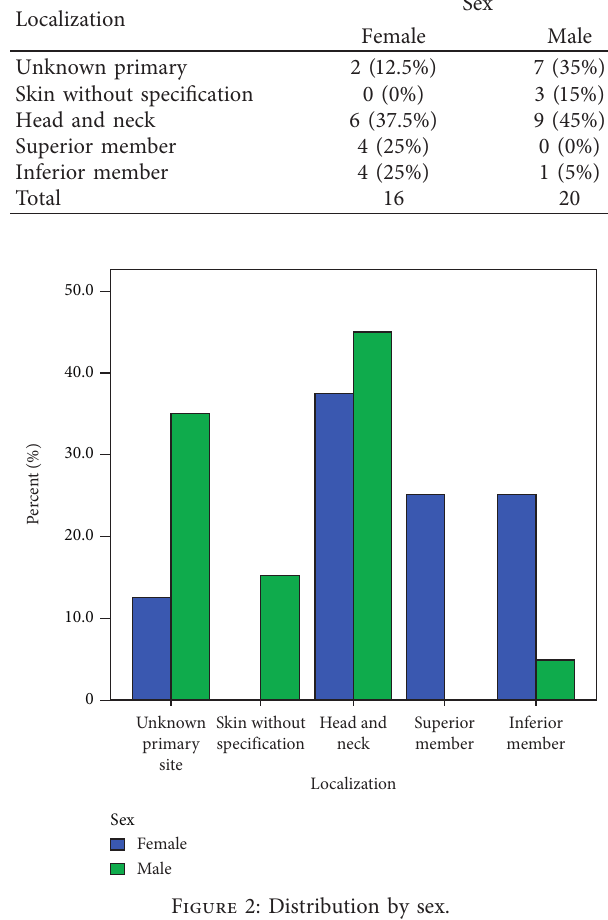
Figure 2: Distribution by